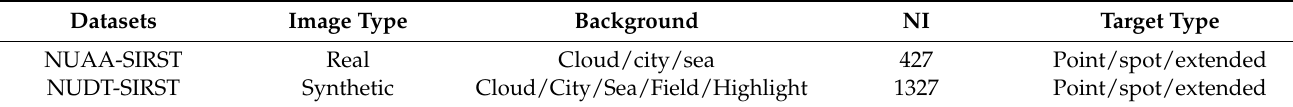
Table 2. Main characteristics of the datasets we